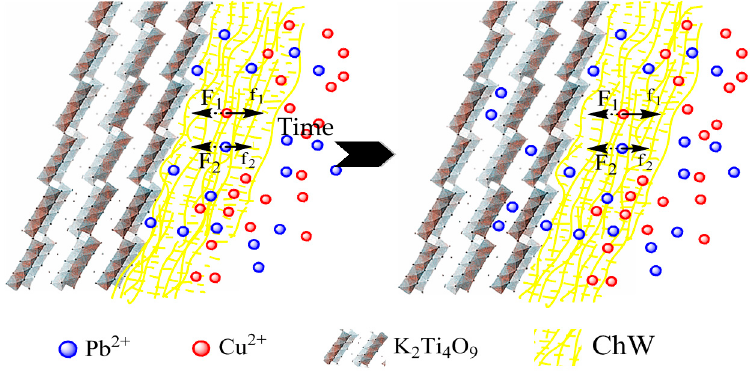
Figure 6. The separation process and mechanism of the double-ion-mixed solution.